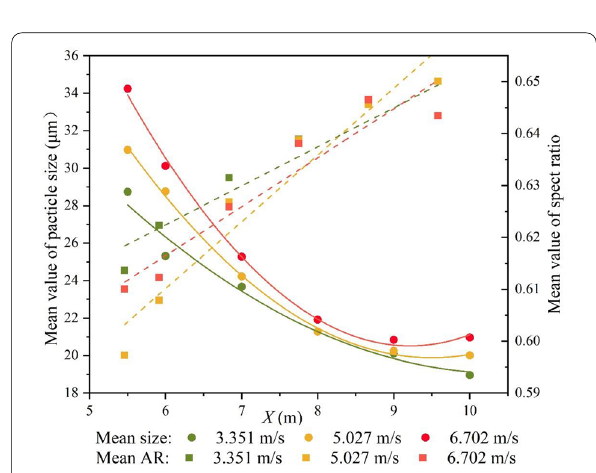
Fig. 11 The means of particle sizes and aspect ratios showed the opposite trend with the increase of X